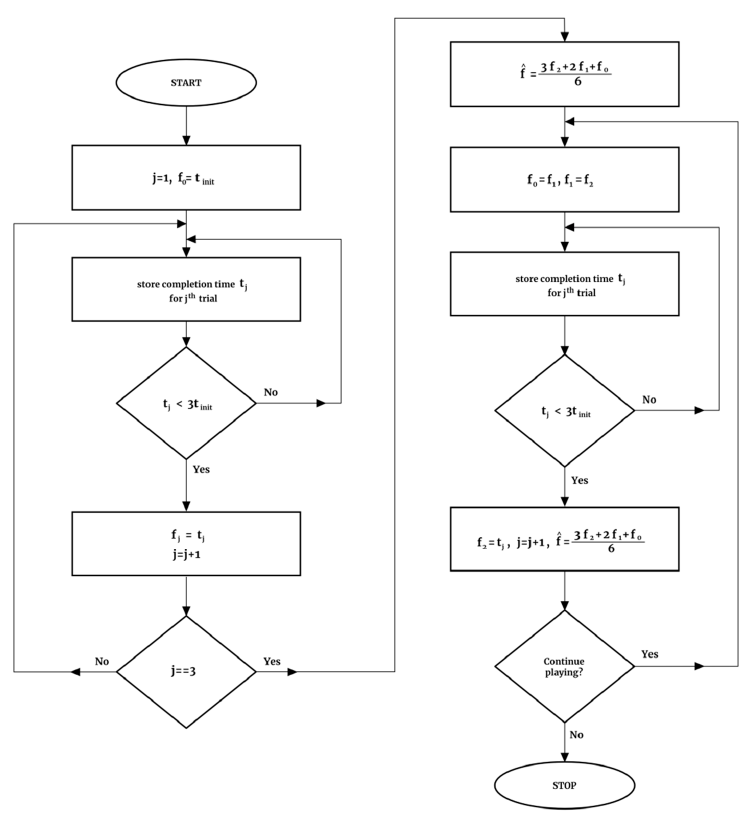
Figure 2. Pseudo-algorithm for the proposed self-learning mechanism.